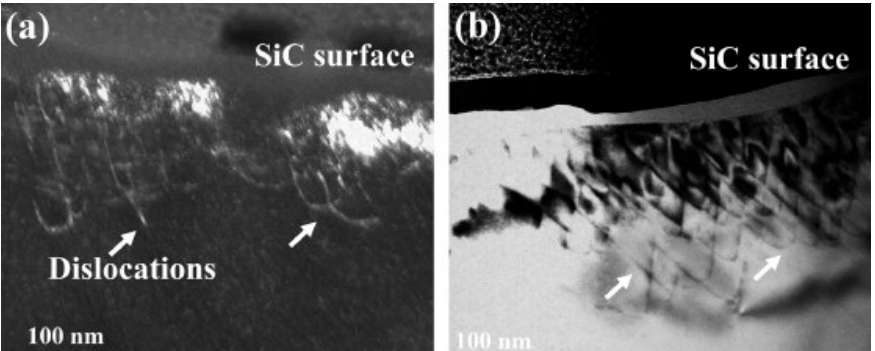
Figure 22. OM showing the microstructure of direct-LSSP-patterned AZ31B with laser intensities of: ( a ) 0; ( b ) 1.18; ( c ) 1.47; ( d ) 1.70; ( e ) 1.92; and ( f ) 2.12 GW/cm². Reproduced with permission from